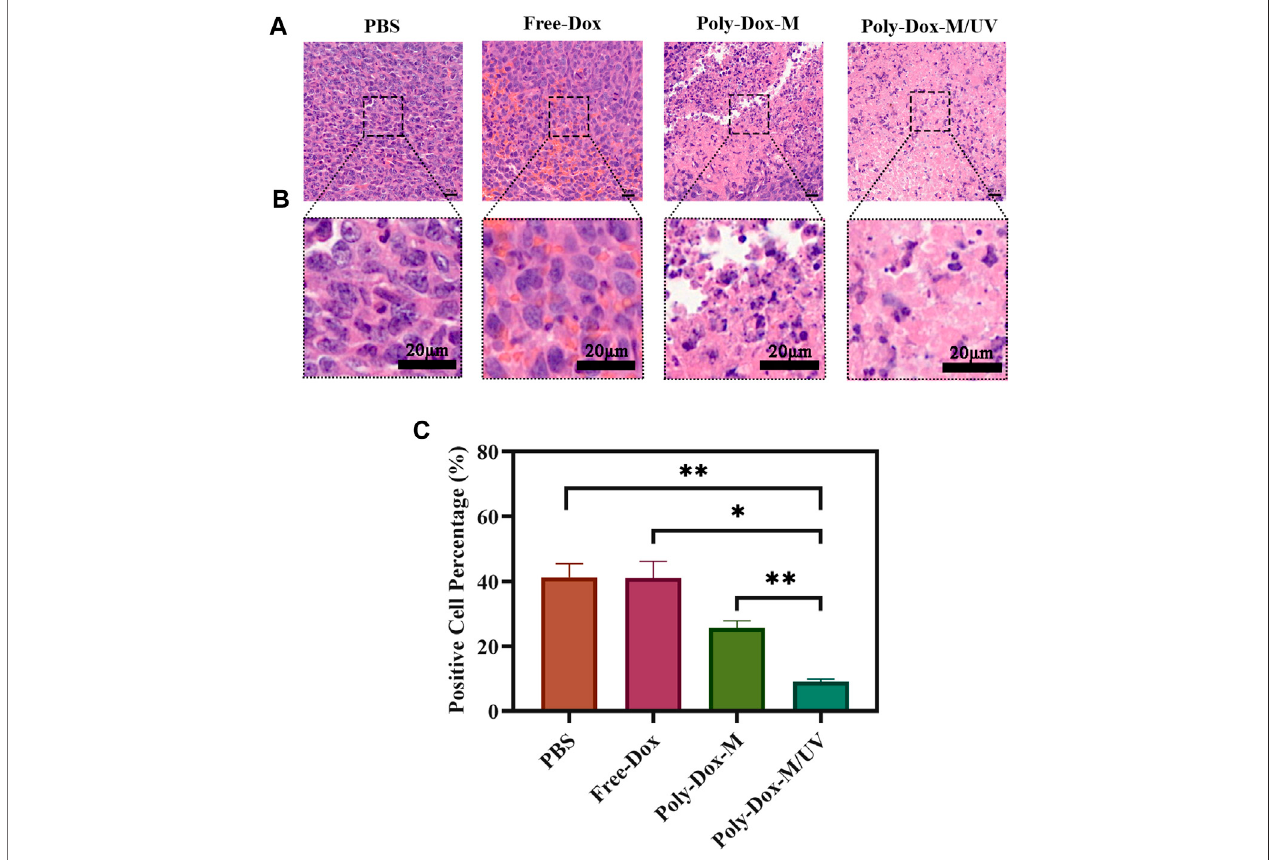
FIGURE 4 | (A) H&E staining of tumor sections extracted from the mice treated with different samples. Scale bar: 20 μ m. (B) An enlarged view of the boxed region below the corresponding image. Scale bar, 20 μ m. (C) Image J analysis of H&E staining (Student ’ s t -test, * p < 0.05, ** p < 0.01, *** p < 0.001).